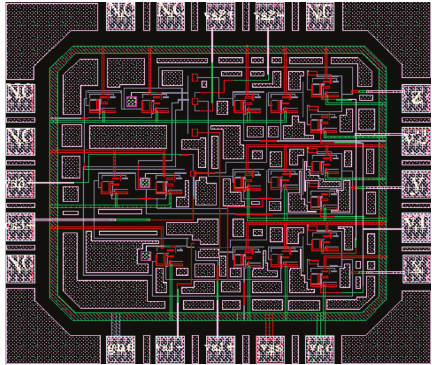
Figure 12: Lyapunov exponents by adjusting α from 0 to 2.